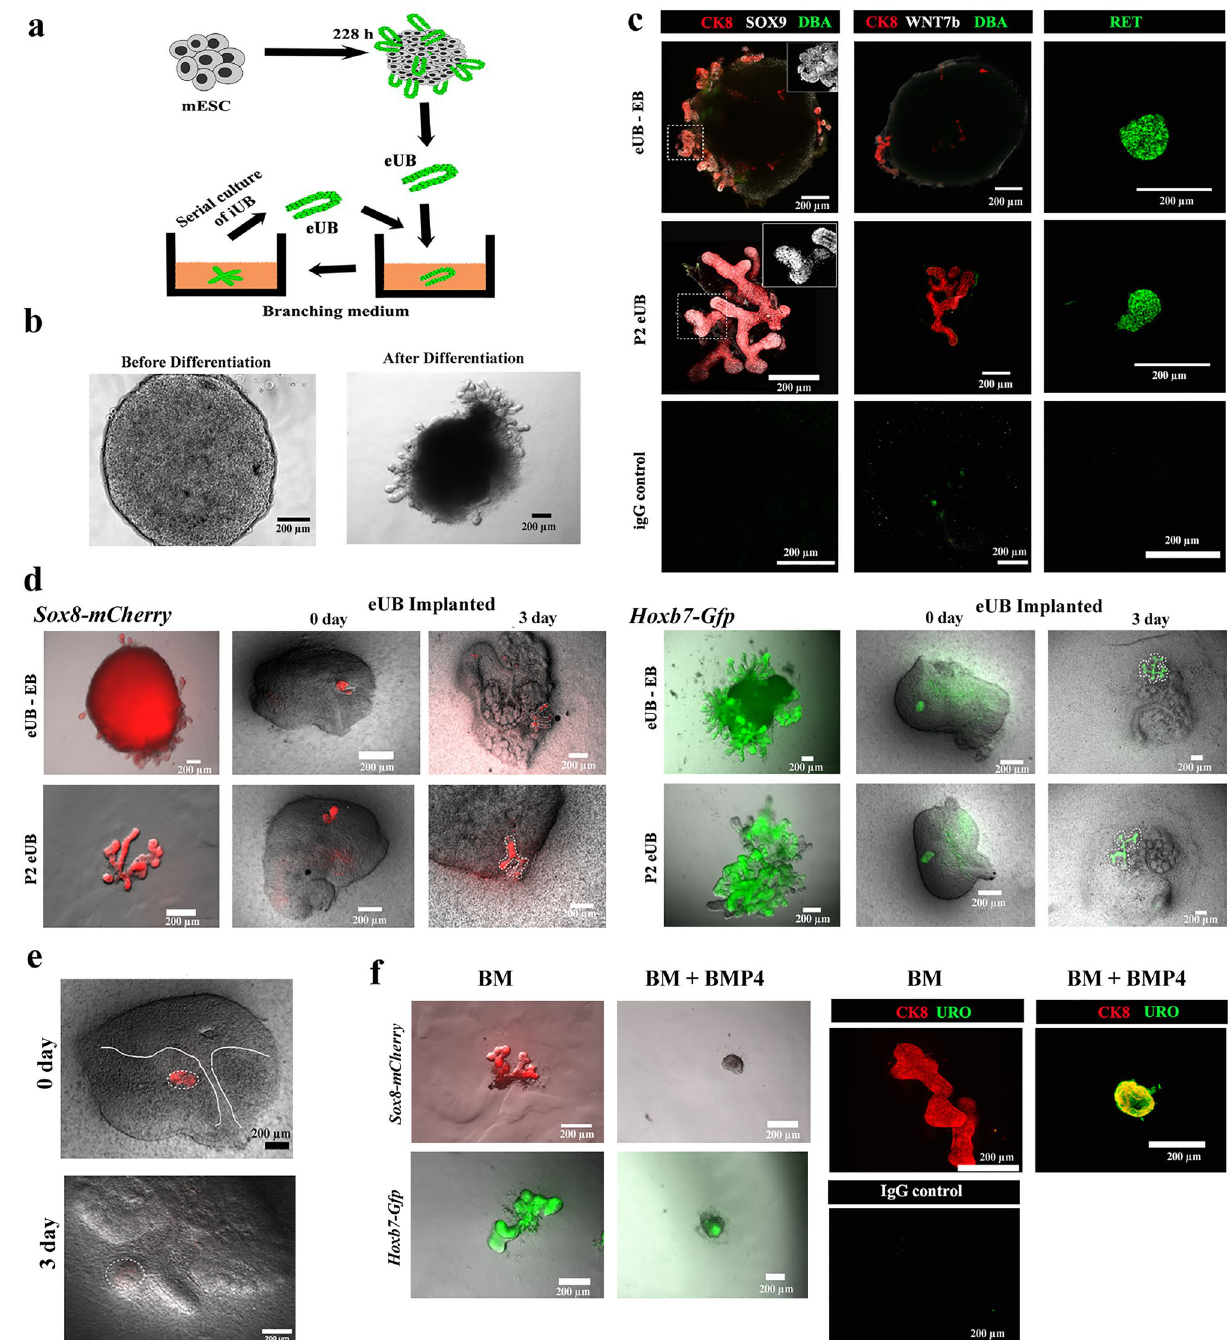
Figure 1. Differentiation of mESC to ureteric bud cells (eUB) ( a ) Schematic diagram showing the isolation and culture of eUBs in branching medium. ( b ) Representative image of embryoid bodies before (48 h) and after differentiation (228 h). Scale bar, 200 µm ( c ) Immunostaining for tip (SOX9, RET) and trunk markers (DBA, WNT7b) in outgrowths from differentiated embryoid bodies (eUB-EB) and passage 2 eUBs (P2 eUB). Cytokeratin 8 (CK8) is a general ureteric bud marker. Inset figure shows the zoomed view of the SOX9 channel in the marked area (dotted line). n = 5/5. ( d ) Fluorescence images of eUBs (derived from Sox8-mCherry and Hoxb7-Gfp lines) implanted in metanephric mesenchyme (from E11.5 kidney), showing branching. eUBs isolated from differentiated embryoid bodies (eUB-EB) and passage 2 eUBs (P2 eUB) were used for implantation studies. Images of kidney at Day 0 and Day 3 after implantation is shown. n = 3/3. ( e ) Fluorescence images of eUBs (derived from the Sox8-mCherry line) implanted in ureteric mesenchyme (from a E11.5 kidney) showing absence of branching at day 3. n = 0/3. ( f ) Branching morphogenesis of eUBs in branching medium (BM) with BMP4 (BM + BMP4) or without BMP4 (BM): BMP4 inhibits branching but promotes expression of uroplakin: n = 3/3 for BM; n = 5/5 for BM + BMP4. Scale bars, 200